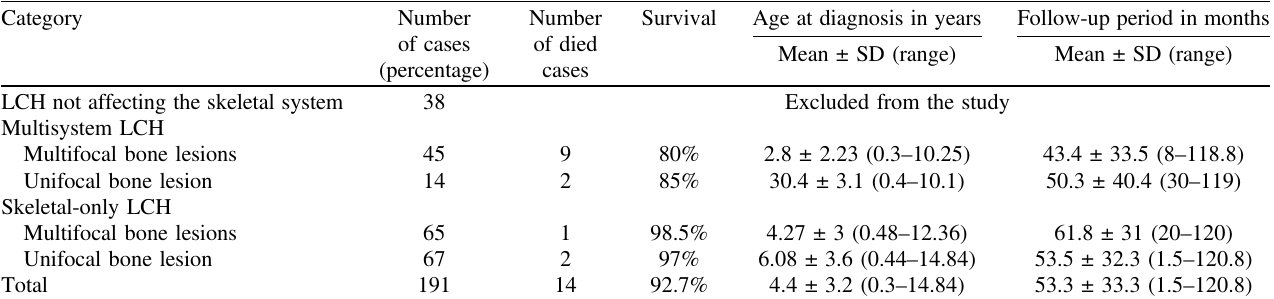
Table 2. Descriptive statistics of study cases, classi fi cation of patients according to histiocytosis Euro Network, survival, age at presentation, and follow-up duration.